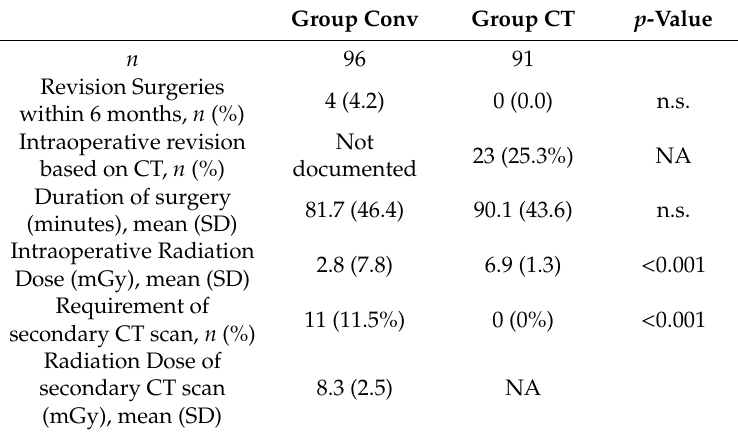
Table 2. Radiographic and intraoperative